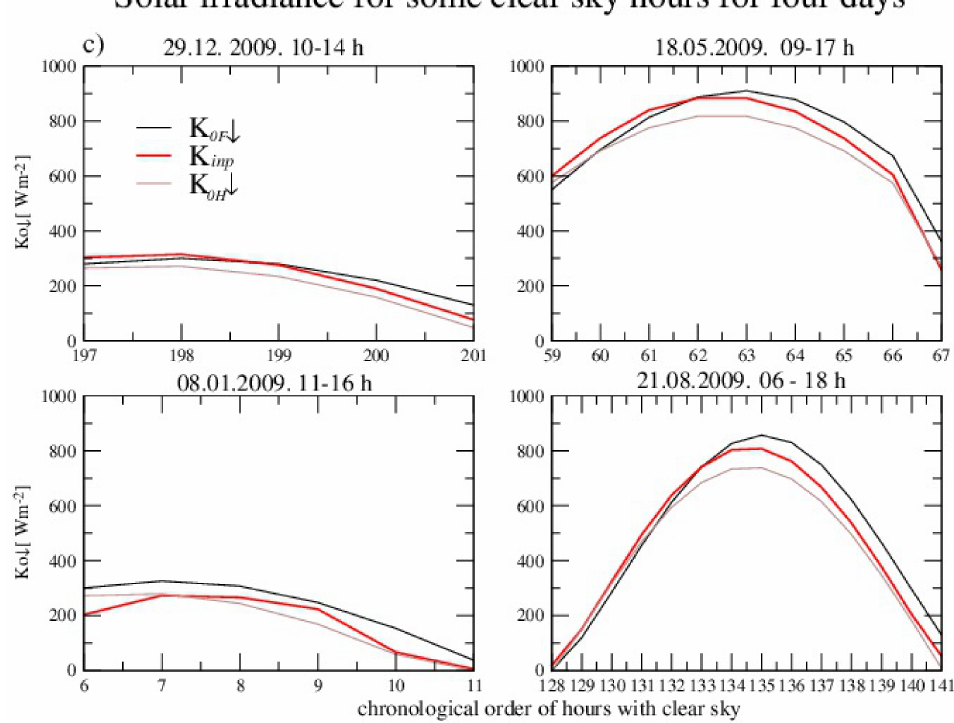
Figure 2. ( a ) Shortwave downwelling solar irradiance for a clear sky obtained by Holtslag’s and Foken’s clear sky calculations for 2009 ( upper panel) and ( b ) during 201 h in chronological order with clear sky conditions in Agrometeorological Observatory Debrecen. The red line represents the measurements (in the middle ). ( c ) Comparison between the measured and calculated K 0 ↓ for four clear sky days in different periods of the year ( lower